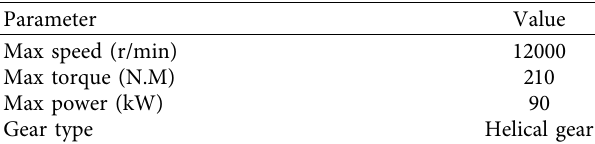
Table 2: Parameters of some secondary